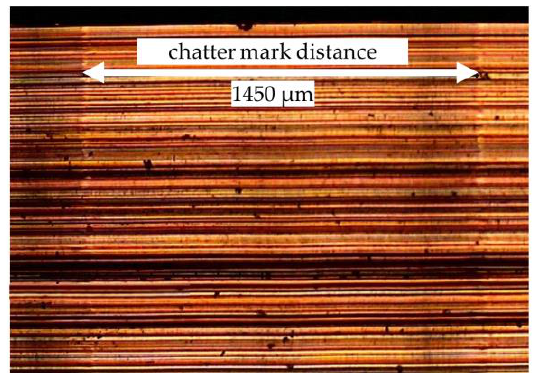
Figure 8. Chatter marks on machined workpiece surface, measured with a phase-contrast microscope.